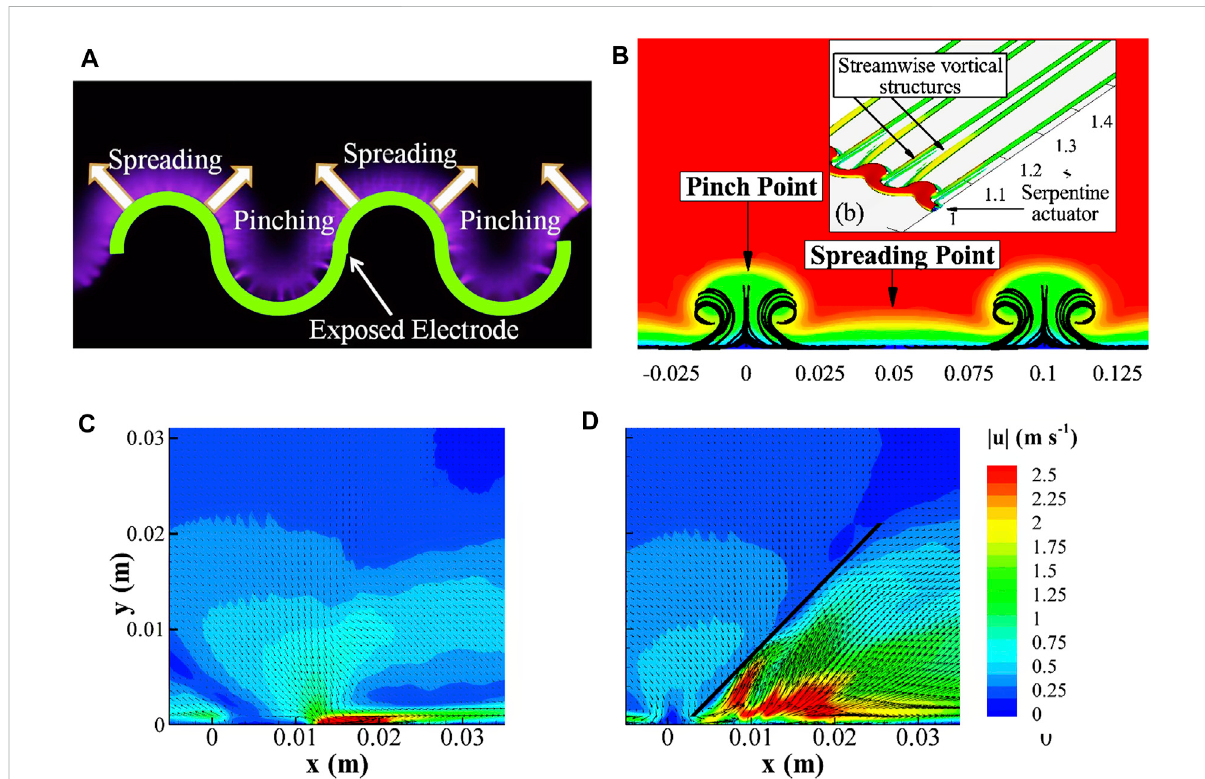
FIGURE 10 (A) Circular serpentine SDBD plasma reactor. (B) Numerical simulation showing the counter-rotating vortex pairs at the pinching region on the x − z plane and also their streamwise propagation. (C) PIV image showing average fl ow velocity in the spreading region. (D) PIV image showing are average fl ow velocity in the pinching region; the twisted jet has an impingement angle, ~38 ° in this example. Images taken from [72,